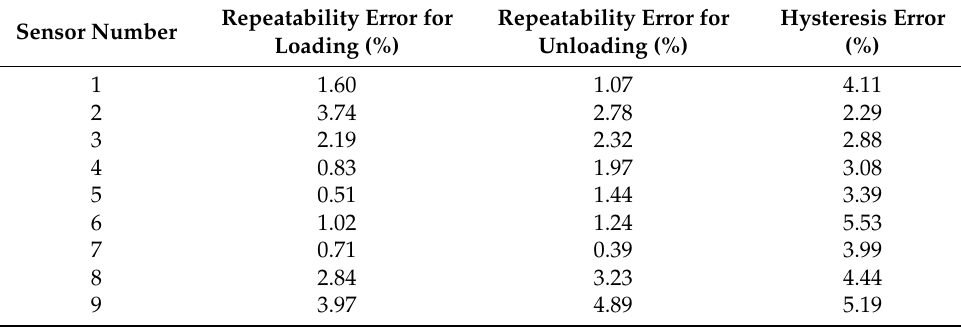
Table 1. Repeatability error and hysteresis error of the sensor